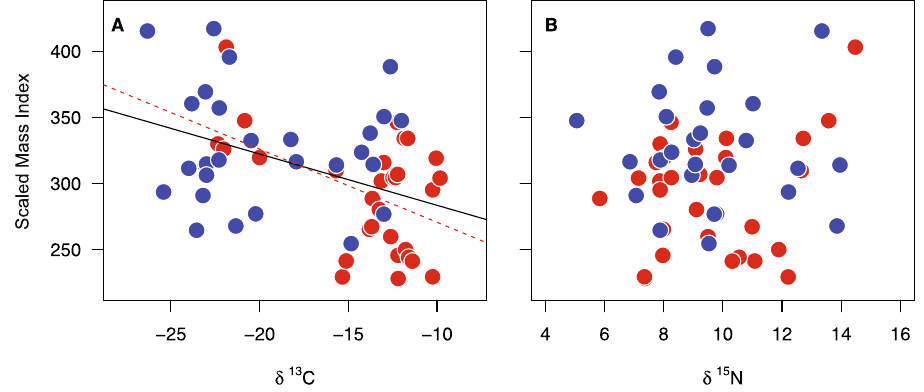
Figure 2. Stable carbon and nitrogen values of primary feathers (P10) moulted in Africa in relation to their size-corrected body mass (Scaled Mass Index; g) in the European staging site. ( ): males, ( ): females. Regression lines are only shown for significant relationships (solid line: males and females combined; dotted line: males).